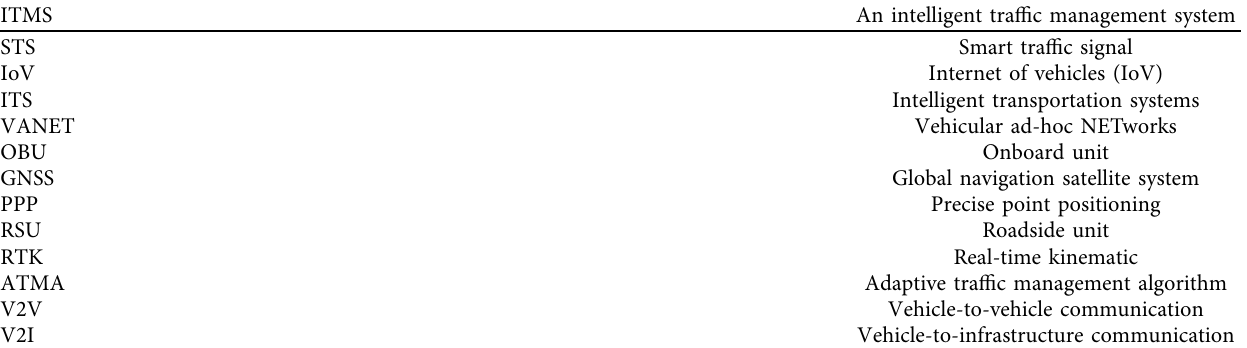
Table 2: Abbreviations used in the paper.